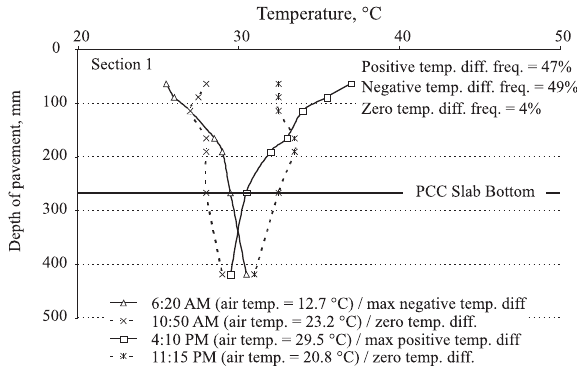
Fig. 5. Pavement temperature distribution with depth in 7 days aft er paving